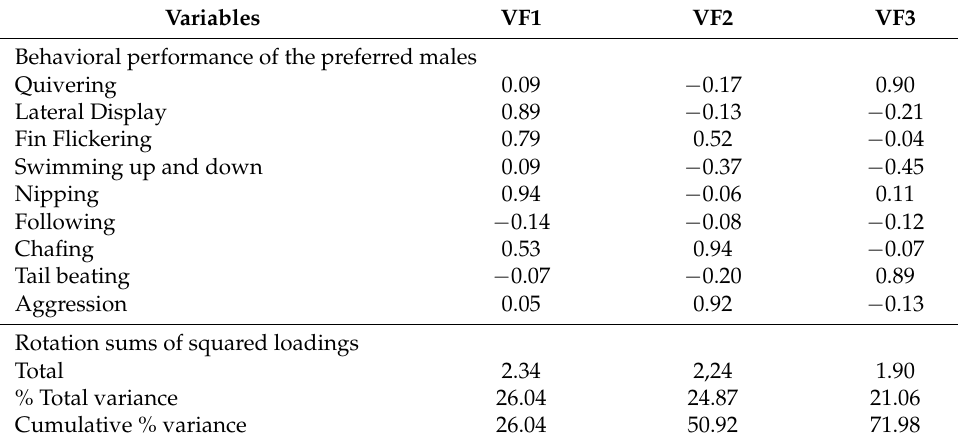
Table 5. PCA outcomes of preferred males of experiment